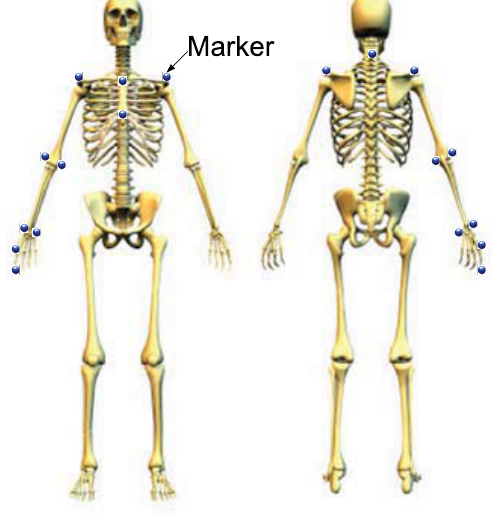
Figure 3: Marker arrangement on a human subject. Totally, 11 markers are used, with 7 mark- ers on the right arm, 3 markers on the trunk, and 1 marker on the left shoulder, opposite to its counterpart at the right